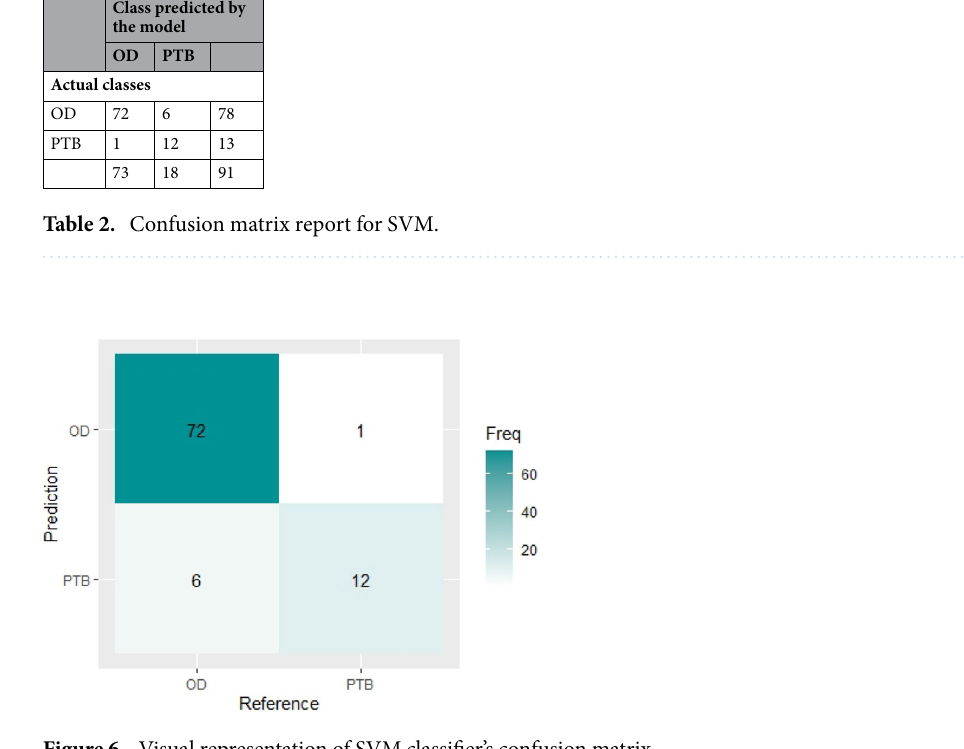
Figure 6. Visual representation of SVM classifier’s confusion matrix.